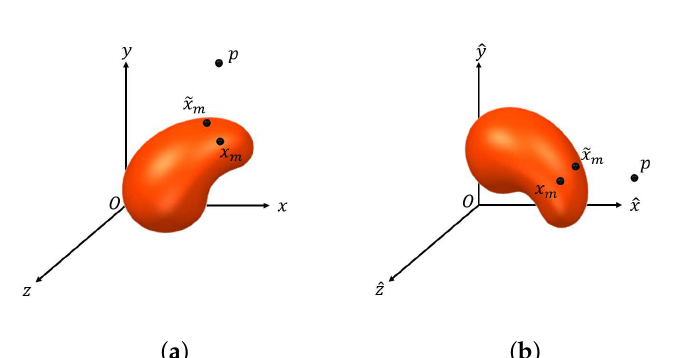
Figure A1. A schematic diagram to show the case of ( a ) x m and ˜ x m being two points on a cashew-shaped surface Ψ 3 D = 0, and p being an external point of { x : Ψ 3 D ≤ 0 } . ( b ) If we rotate Ψ 3 D = 0 in ( a ) to a new coordinate system, denoted by ( ˆ x , ˆ y , ˆ z ) , with a proper rotation matrix, we have that p , x m , and ˜ x m have the same ˆ y